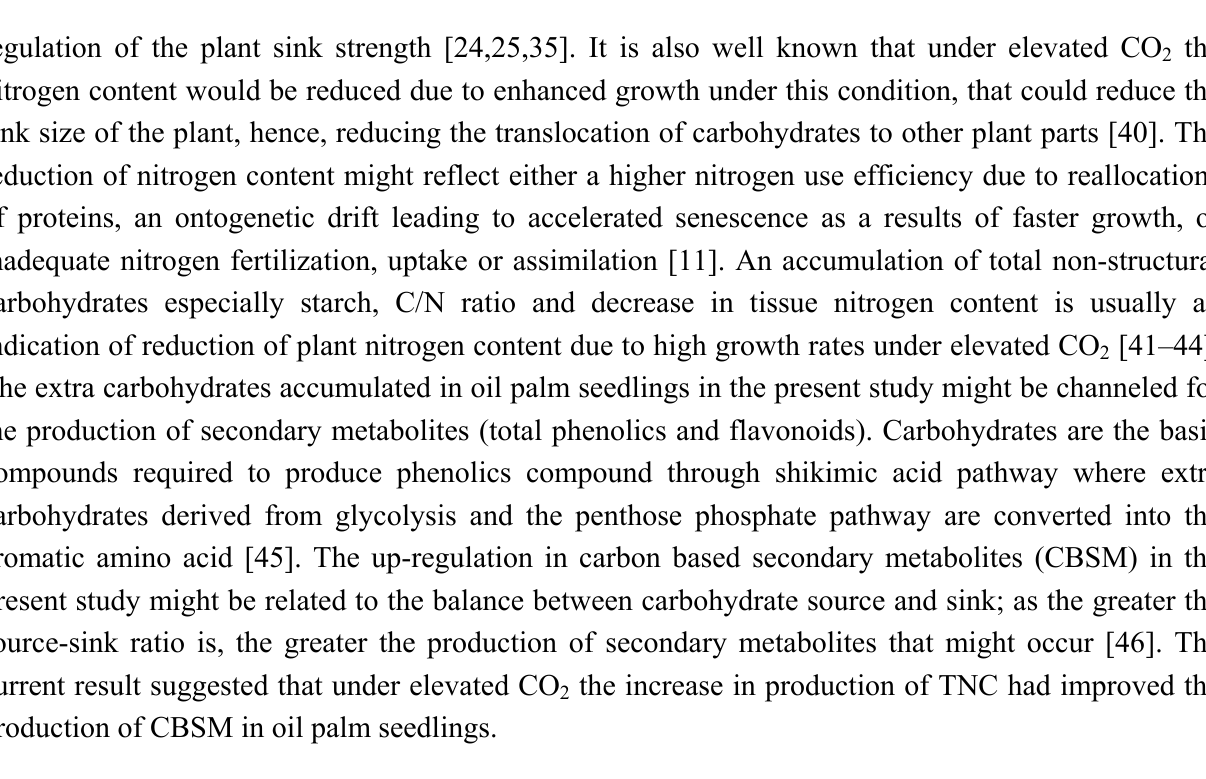
concentrations on some biochemical parameters in 2